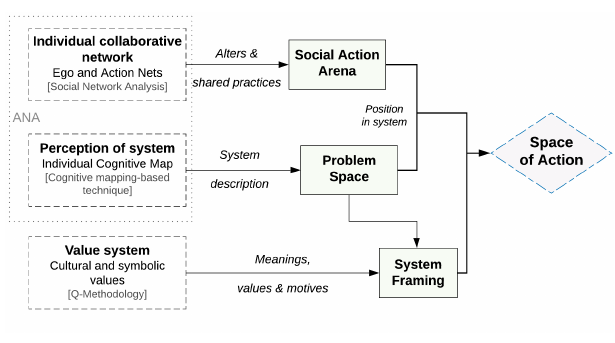
Fig. 4. Flowchart showing how individual agency is identified.